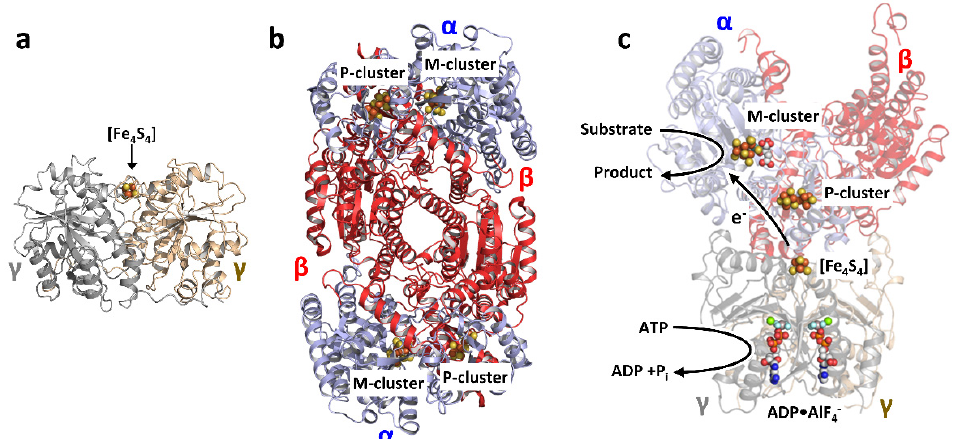
Figure 1. The Mo-nitrogenase of Azotobacter vinelandii . Crystal structures of ( a ) the nucleotide-free, γ 2 -dimeric Fe protein (PDB entry 2nip); ( b ) the α 2 β 2 -tetrameric MoFe protein (PDB entry 3u7q); and ( c ) one half of the MgADP • AlF 4 − -stabilized Mo-nitrogenase complex comprising one γ 2 -dimeric Fe protein and one αβ -dimer of the tetrameric MoFe protein (PDB entry 1n2c), which permits ATP- dependent, interprotein electron transfer from the [Fe 4 S 4 ] cluster of the Fe protein, via the P-cluster ([Fe 8 S 7 ]), to the M-cluster ([( R -homocitrate)MoFe 7 S 9 C]) of the MoFe protein during catalysis. The two component proteins of the Mo-nitrogenase are shown as ribbons, with the two subunits of the Fe protein colored light yellow and light gray, respectively ( a ), and the α - and β -subunits of the MoFe protein colored blue and red, respectively ( b ). The [Fe 4 S 4 ] cluster of the Fe protein ( a , c ), the P- and M-clusters of the MoFe protein ( b , c ), and the MgADP • AlF 4 − entity ( c ) are shown in ball-and-stick presentation, with the atoms colored as follows: Fe, orange; S, yellow; Mo, cyan; C, light gray; Mg, green; O, red; Al, dark gray; F, light blue; P, dark orange.